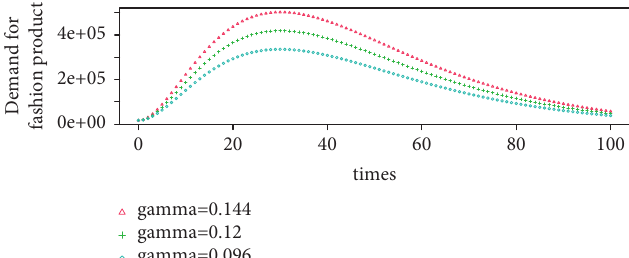
Figure 10: Time series simulation of the demand for fashion products at three different rates ( c ) of control of safety measures to enforce the application of FPPEs. The rate of enforcing safety measures such as the application of FPPEs increases (from 0.096 to 0.144), and the demand for fashion products shifts bodily outward, indicating an increase in demand.